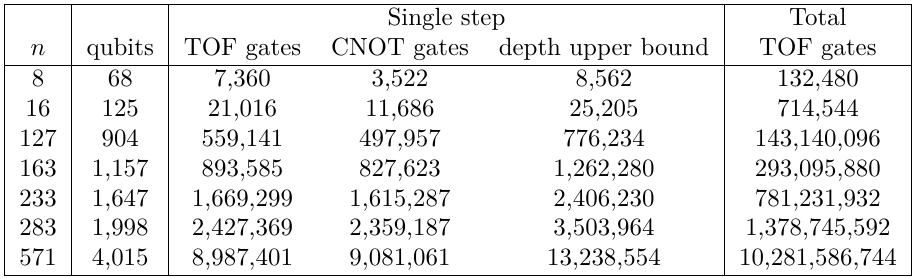
Table 5: Qubit and gate count for Shor’s algorithm for binary elliptic curves. Field polynomials from Table 1. CNOT count given is an upper bound.